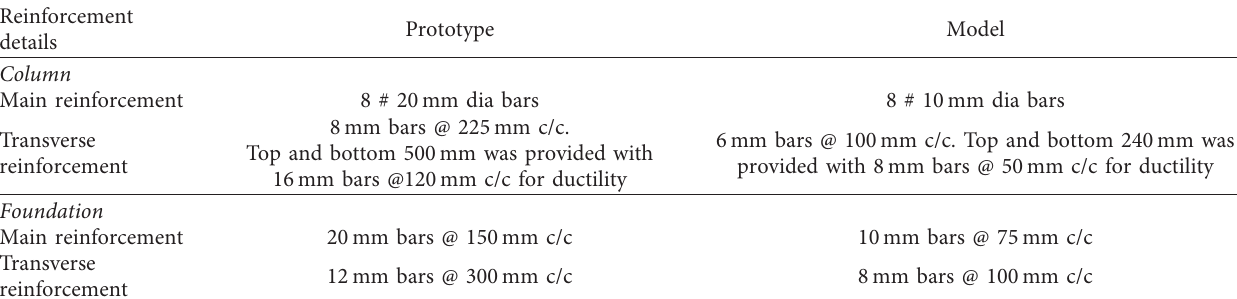
Table 3: Reinforcement details of the column and